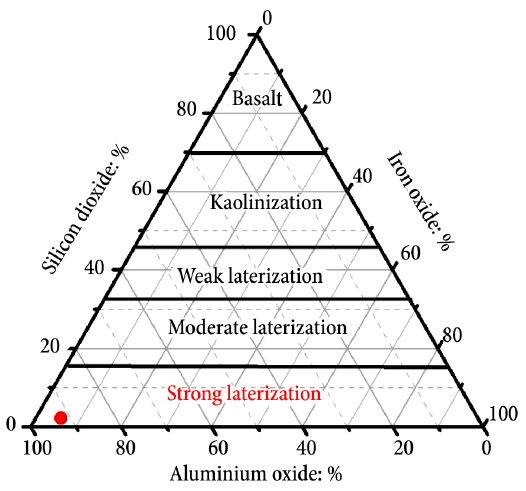
Figure 2. Ternary plot of natural soil sample